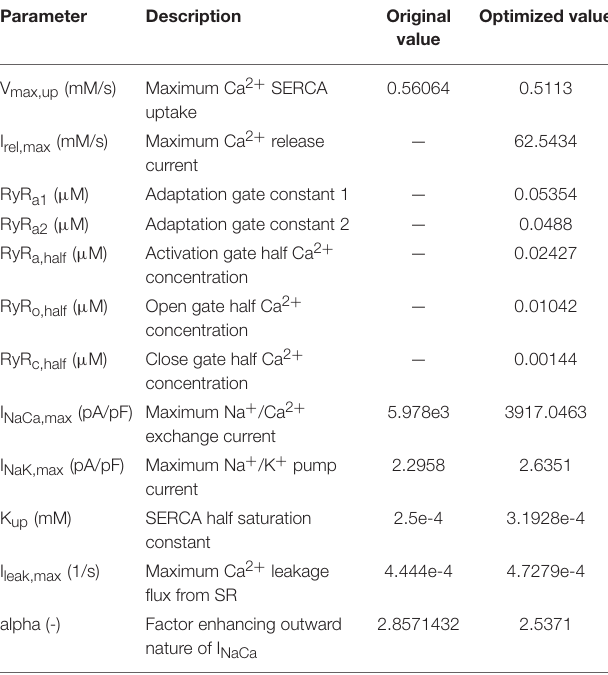
the parameter optimization. Biomarker Weight in the cost function